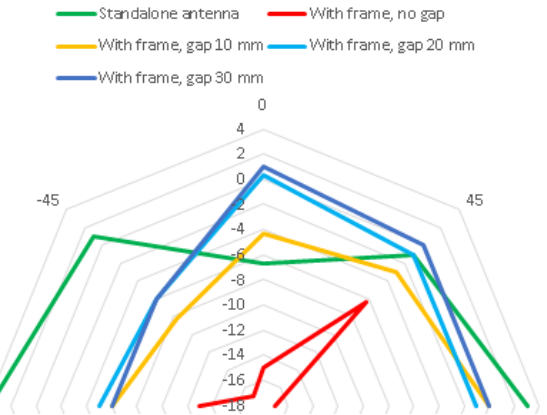
Fig. 6. Illustration of the orientation of the frame and communication module in the vertical